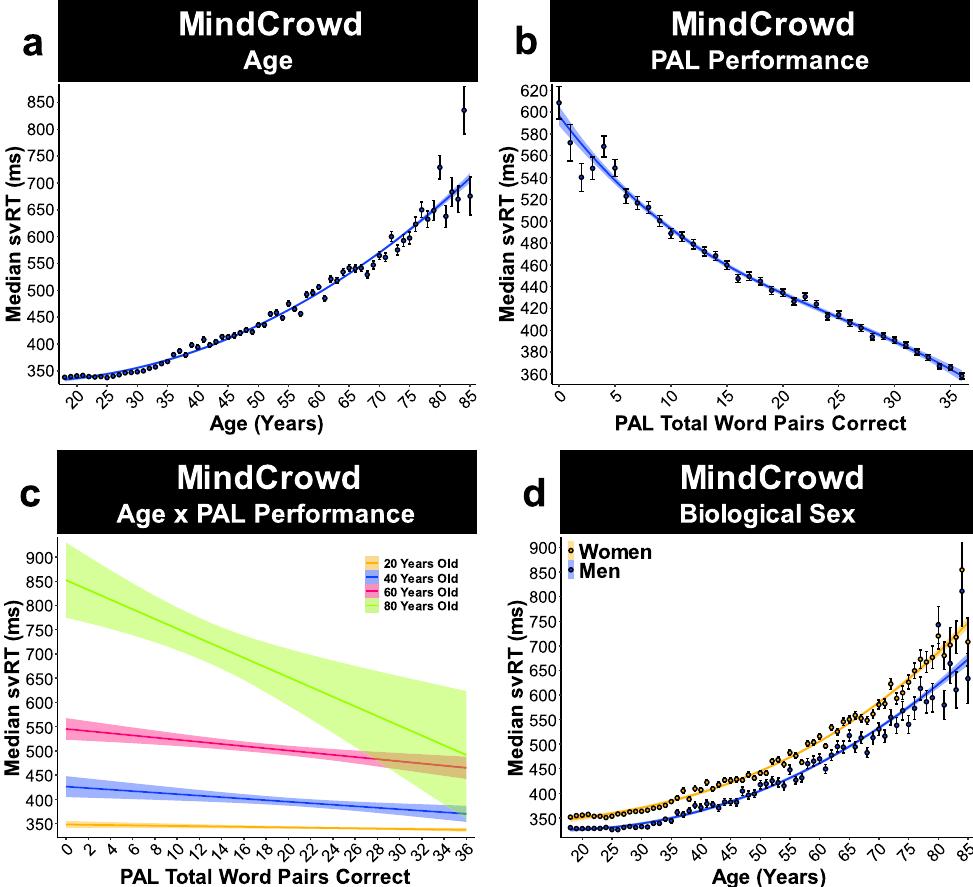
Fig. 1 MindCrowd: age, paired-associate learning (PAL), and biological sex. MindCrowd analysis (ages 18 – 85) of simple visual reaction time (svRT). a Linear model fi ts (line fi ll ±95% CI, error bars ± SEM) of the median svRT by Age3 (curvilinear model). There was a curvilinear relationship between svRT and Age 1 ( β Age 1 = 7.07, p Age 1 = 3.06E − 18), Age 2 ( β Age2 = − 0.15, p Age2 = 3.23E − 17), and Age 3 ( β Age3 = 1.47E − 03, p Age3 < 1.46E − 34, n = 75,666). b Linear model fi ts (line fi ll ±95% CI, error bars ± SEM) of the median svRT by Age3 (curvilinear model). There was a curvilinear relationship between svRT and paired-associate learning (PAL) performance PAL Performance 1 ( β PAL1 = − 8.89, p PAL1 = 3.77E − 34), PAL Performance 2 ( β PAL2 = 0.32, p PALl2 = 2.35E − 14), and PAL Performance 3 ( β PAL3 = − 4.13E − 03, p PAL3 = 7.28E − 09, n = 75,666). c Simple slope analysis of the linear model fi t (line fi ll ±95% CI, error bars ± SEM) for the Median svRT× PAL Performance interaction ( β Age*PAL = − 0.07, p Age*PAL = 1.26E − 59). At 20 ( β Age20*PAL = − 5.48, p Age20*PAL < 0.00, n = 1985), 40 ( β Age40*PAL = − 6.41, p Age40*PAL < 0.00, n = 739), 60 (